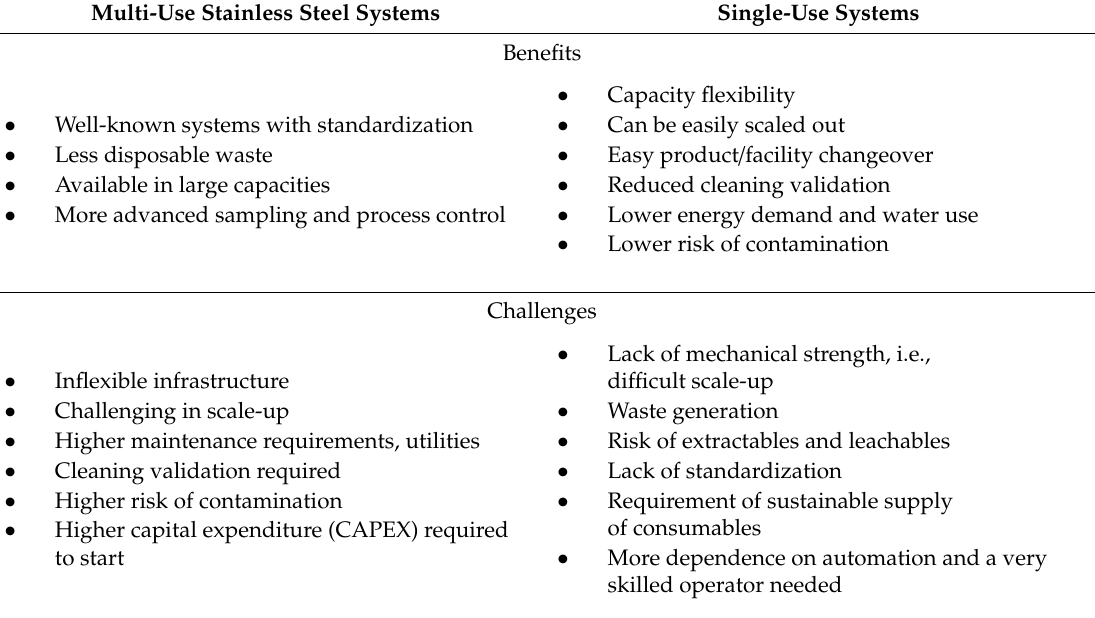
Table 2. Benefits and challenges that single-use systems can o ff er compared to stainless steel-based manufacturing